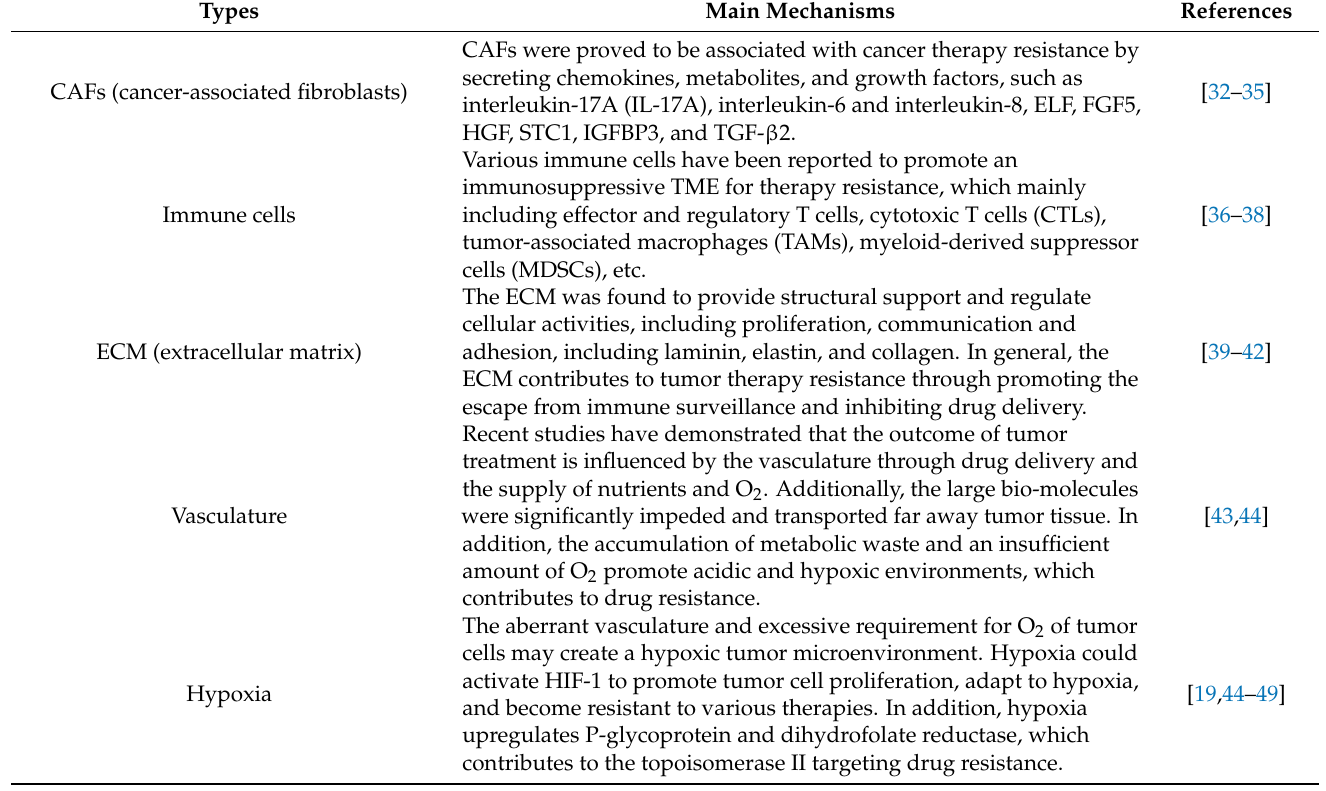
Table 1. Various TME components for immunotherapy resistance focused on in this